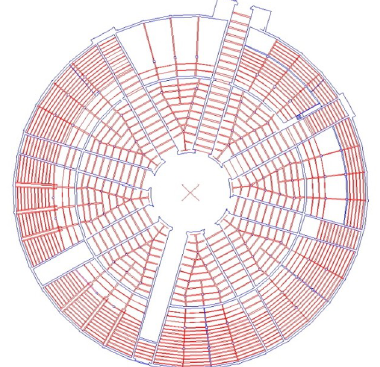
Figure 8. Restitution of detailed geometry of the structures of the ground floor produced by the integration of plan and information from the virtual scan.